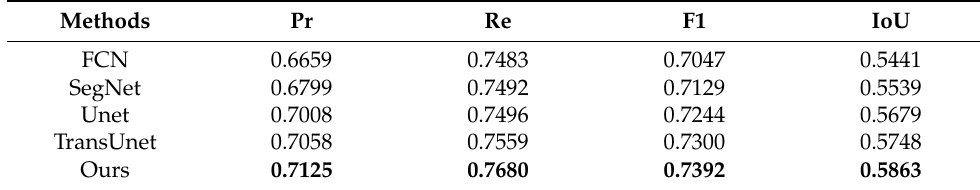
Table 2. The Pr, Re, F1, and IoU of the compared methods for the CFD dataset.